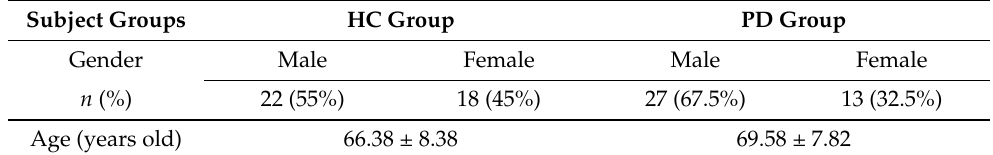
Table 1. Subject groups of HC and PD patients, with the age statistics presented as mean ±